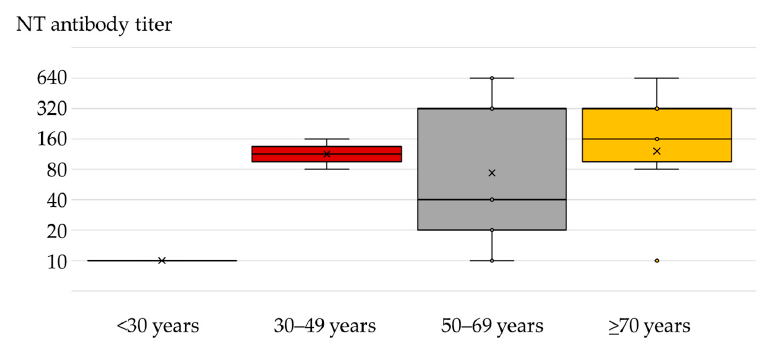
Figure 2. Median (interquartile range) and mean (×) TAHV-neutralizing antibody titers in patients with neuroinvasive disease according to age. The geographic distribution of TAHV seropositive patients is presented in Figure 3. Patients were from nine Croatian counties, eight continental counties, and one county on the Croatian littoral (Figure 3A,B,D). The majority of patients (20/22; 90.9%) were residents of floodplains along the rivers Drava, Bednja, and Mura (B1), Drava and Danube (B2), Sava (B3), and Dobra (B4). The average altitude at which seropositive patients resided was 128 m above sea level (range 12–323 m). Note that location B5 is on the Adriatic Coast at the mouth of the Rje č ina River, 12 m above sea level. Figure 3. Geographic distribution of TAHV seropositive patients: counties with reported cases are shadowed in dark red ( A ); regions (1–5) with reported cases are circled ( B ); distribution of